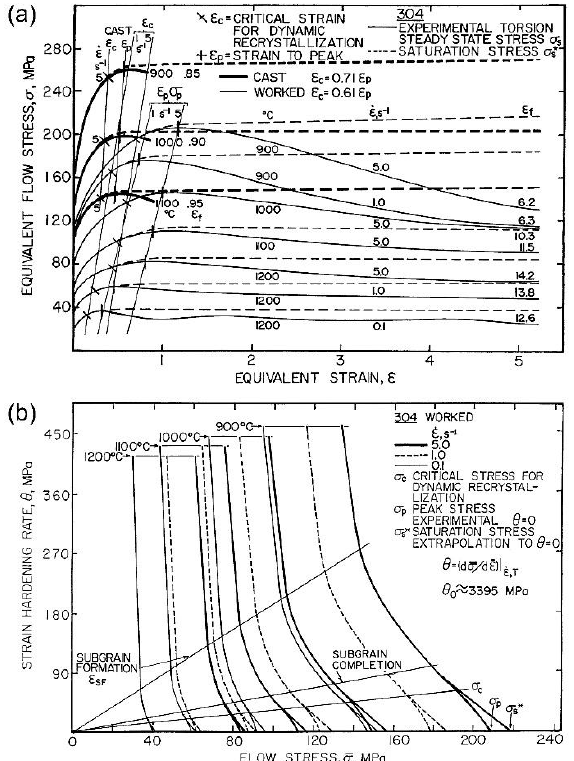
Figure 4. (a) Experimental flow curves of an AISI 304 steel and (b) corresponding experimental θ–σ curves and hypothetical strain hardening rate–stress curves (DRV). Reprinted from [78] with permission from Elsevier.